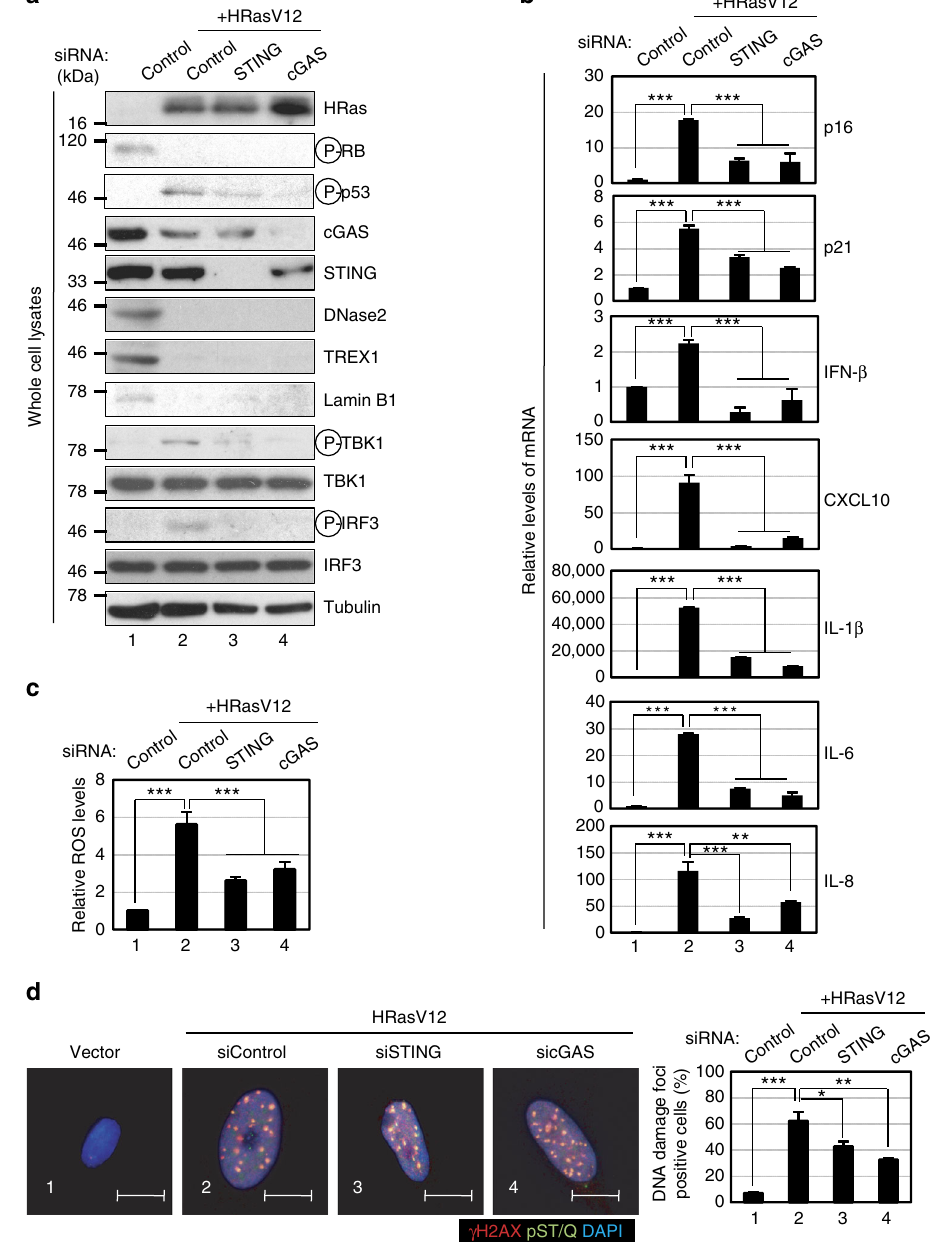
Fig. 2 Induction of SASP by activating the cytoplasmic DNA sensing pathway. a Senescent TIG-3 cells induced by oncogenic Ras expression (lane 2 – 4) were transfected with previously validated siRNA oligos indicated at the top of the panel for twice at 2 day intervals. These cells were then subjected to western blotting using antibodies shown right ( a ), RT-qPCR analysis of SASP factor gene expression ( b ), analysis of intracellular ROS levels ( c ) or immuno fl uorescence staining for markers of DNA damage ( γ -H2AX [red], phosphor-Ser/Thr ATM/ATR (pST/Q) substrate [green] and 40,6-diamidino- 2-phenylindole [blue]) on day 4 ( d ). The representative data from three independent experiments are shown. Tubulin was used as a loading control ( a ). For all graphs, error bars indicate mean ± standard deviation (s.d.) of triplicate measurements. (* P < 0.05. ** P < 0.01. *** P < 0.001; one-way ANOVA). Scale bars, 10 μ m ( d